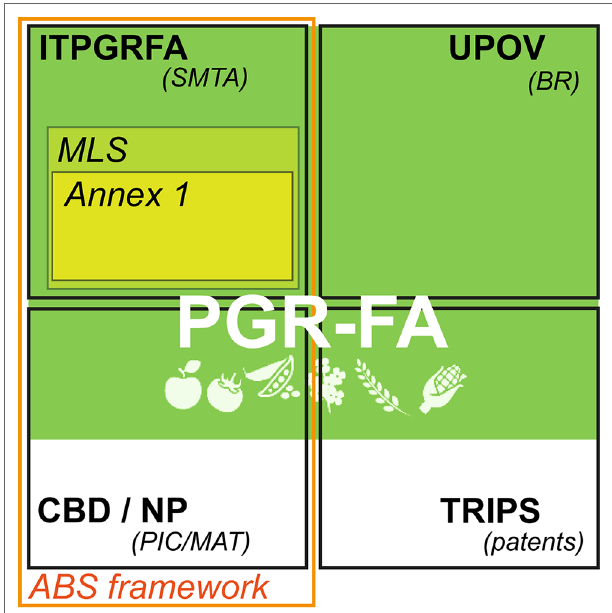
FIGURE 1 | The regime complex regulating Plant Genetic Resources for Agriculture (PGRFA). ITPGRFA, International Treaty for Genetic Resources for Food and Agriculture; SMTA, Standard Material Agreement; MLS, Multi- lateral System; UPOV, International Union for the Protection of New Varieties of Plants; BR, Breeder's right; CBD, Convention for Biodiversity; NP Nagoya Protocol; PIC/MAT, Prior Informed Consent/Mutually Agreed Terms; TRIPS, Agreement on Trade-Related Aspects of Intellectual Property Rights; ABS Access and Benefit